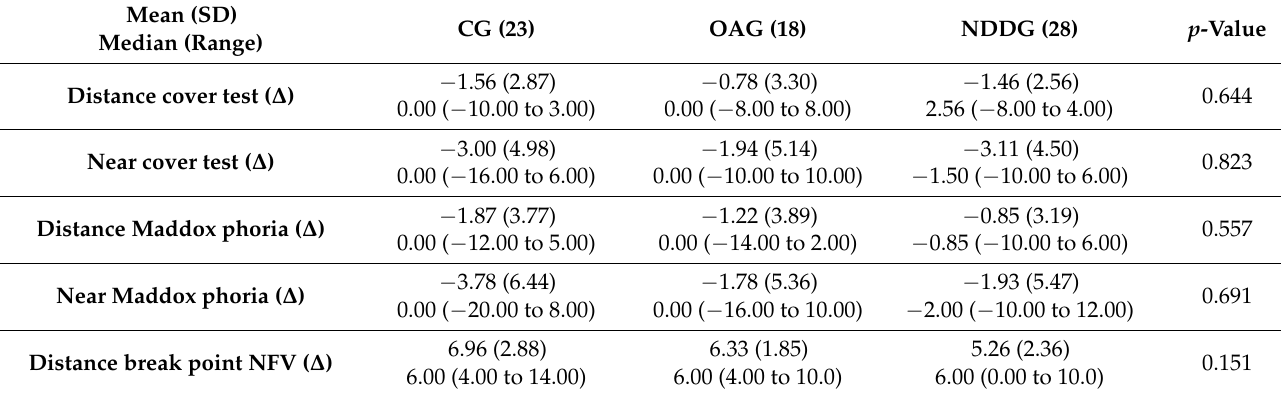
Table 5. Summary of the results of the binocular examination in the three groups of children evaluated: CG, control group; OAG, group of children with oculomotor abnormalities; NDDG, group of children with neurodevelopmental disorders. Mean